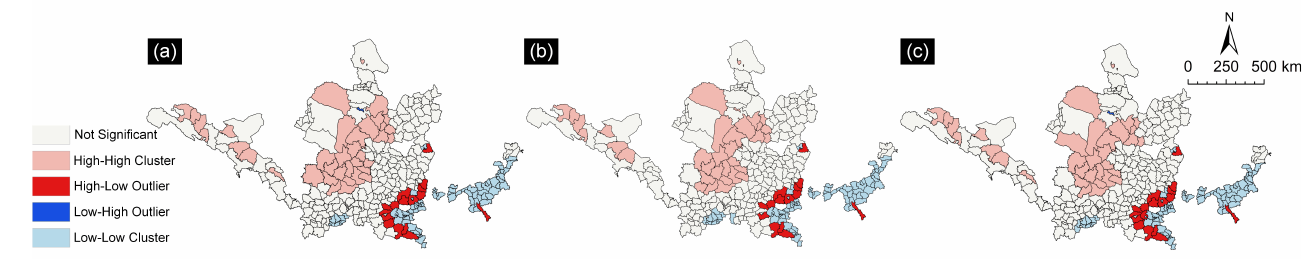
Figure 6. Local autocorrelation map of the coordination degree of the ES supply-demand of resource- based cities in the YRB. ( a ) 2000; ( b ) 2010; ( c )